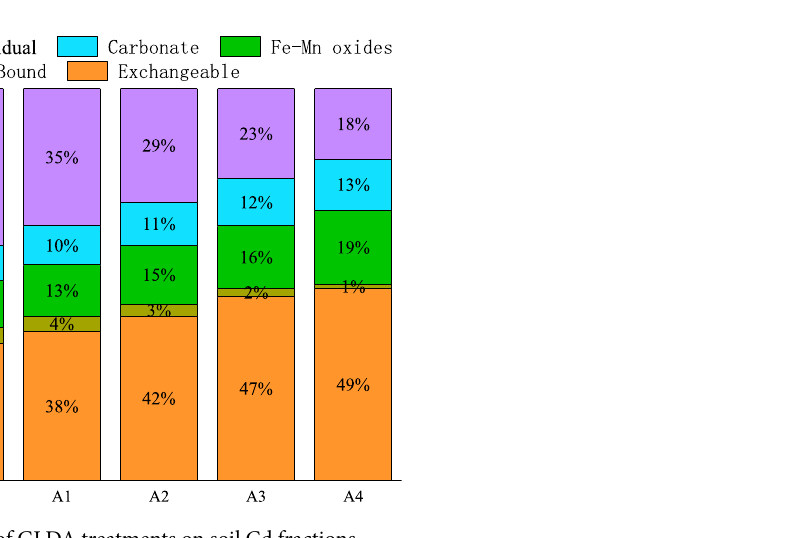
Figure 4. Effects of GLDA treatments on soil Cd